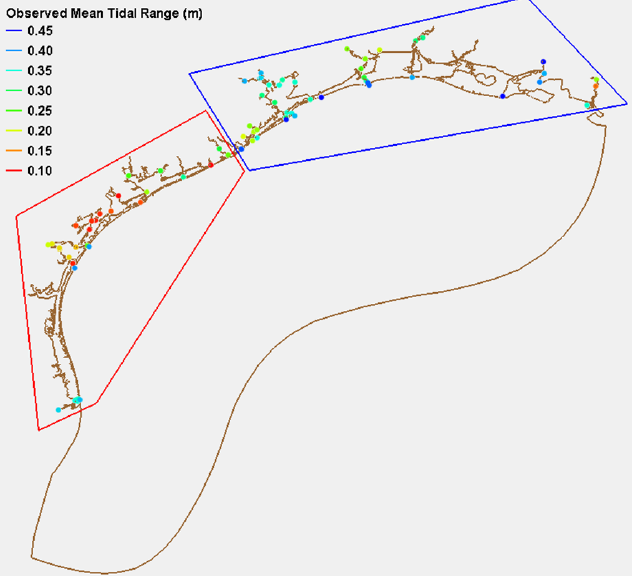
Figure 6. The mean tidal ranges from the 75 tide stations. The blue polygon includes 43 tide stations from Houston to the east (with a mean tidal ranges of 0.33 m), and the red polygon includes 32 tide stations from Houston to the west (with a mean tidal ranges of 0.23